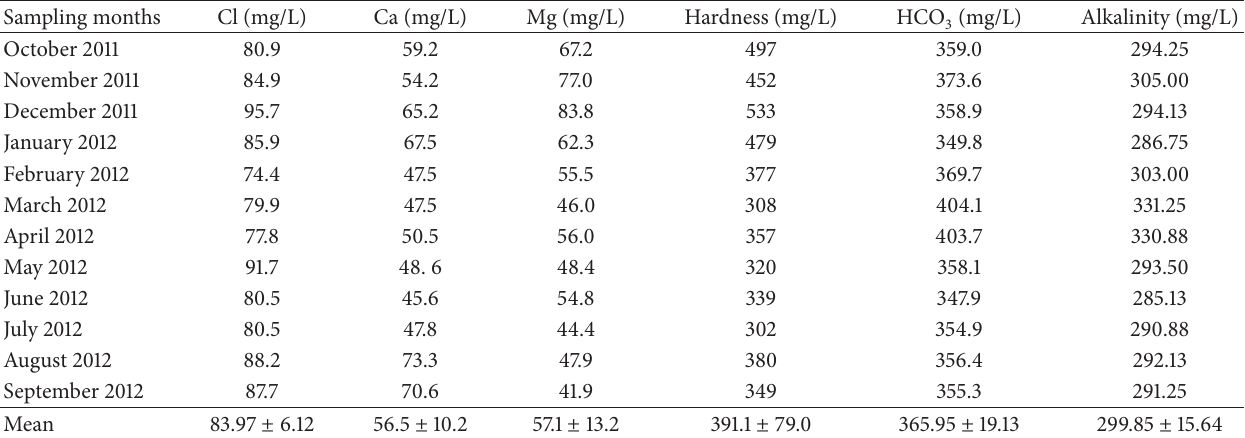
Table 2: Data obtained from titrimetric analysis conducted on Bulakbas¸ı